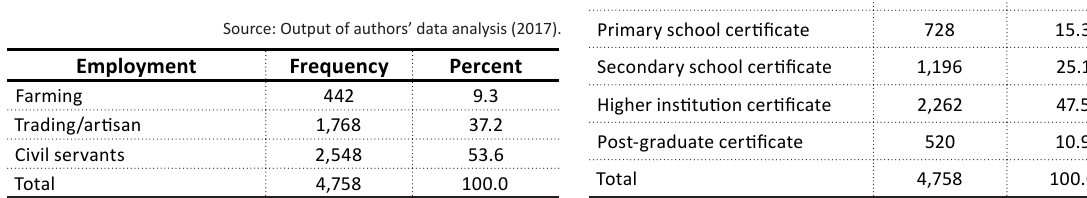
Table 5. Employment distributions of households